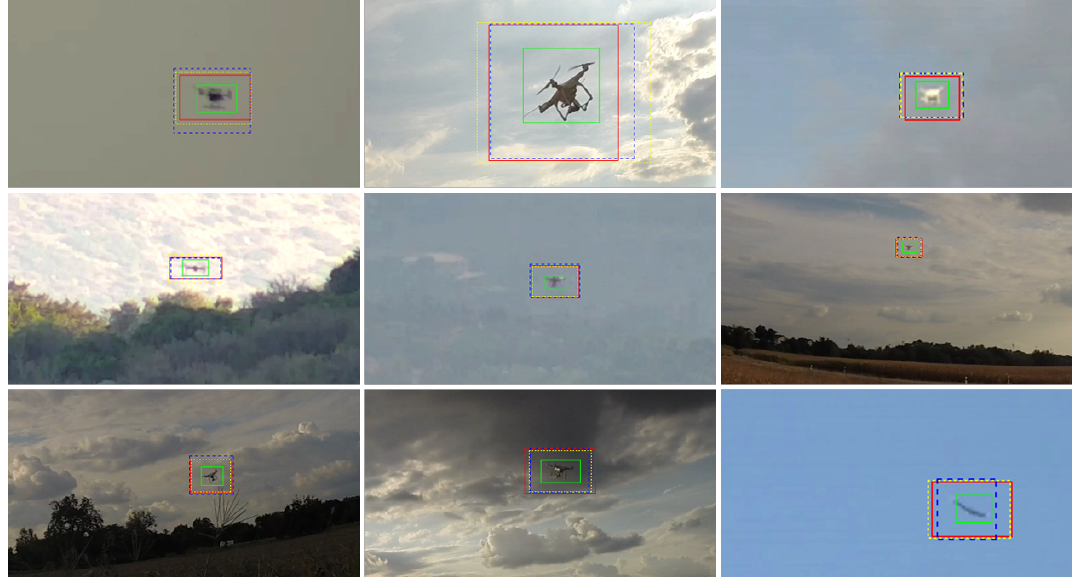
Figure 23. Images crops showing qualitative detection results and the corresponding GT (green). Note that the detec- tion results from Team Alexis (red), Team Eagledrone (blue) and Team Gradient (yellow) are enlarged to simplify the visualization. All methods achieve good detection results for different drone types and a large range of drone sizes in different environments.